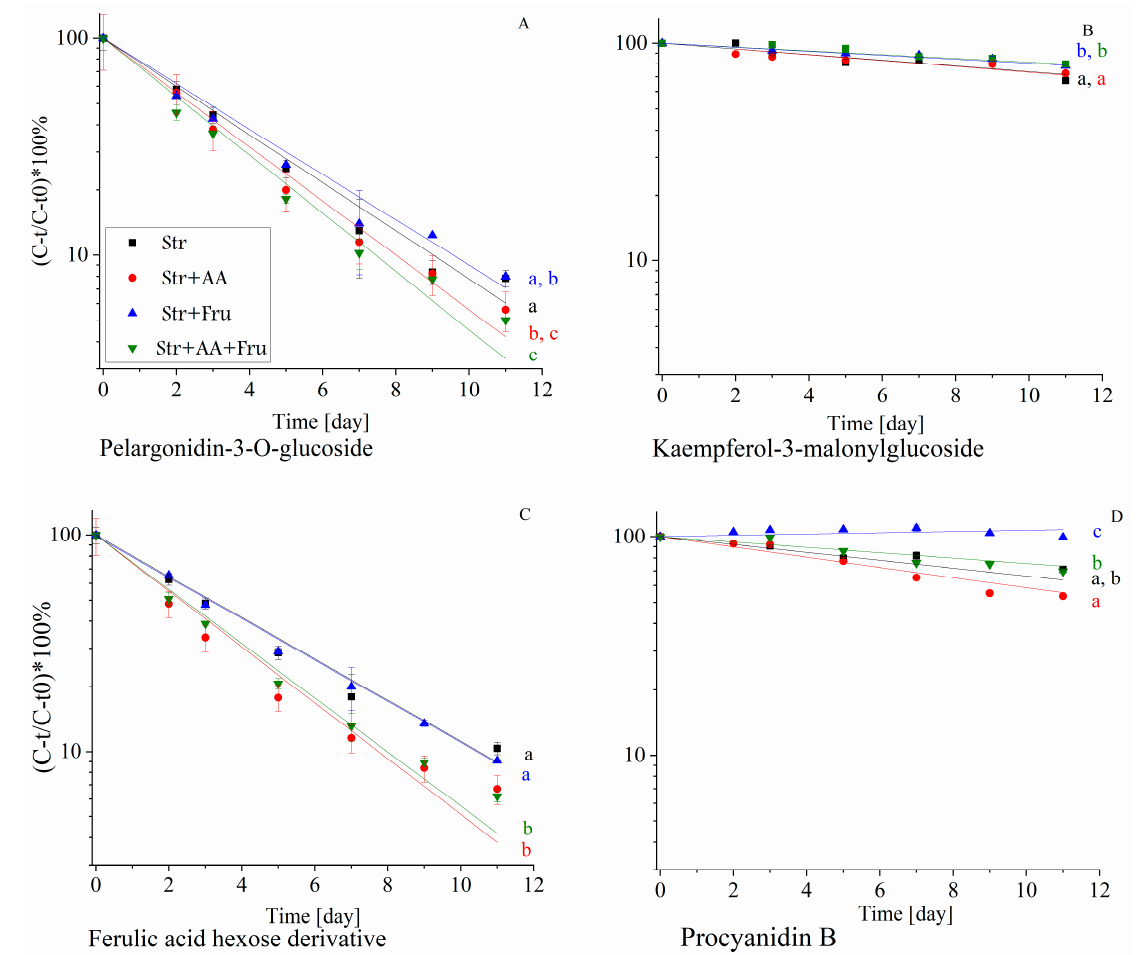
Figure 5. Relative concentration of polyphenols in the extract during shelf-life at 37 °C (citric buffer pH = 3, 50 mM) as function of the presence of ascorbic acid (AA, 0.022%) and fructose (Fru, 10%) ( A ) pelargonidin-3- O -glucoside, ( B ) kaempferol-3- O -malonylglucoside, ( C ) ferulic acid hexose derivative, ( D ) procyanidin B. * Error bars represent standard error (n = 2). * Small letters near the regression line represent significant differences ( p < 0.05), according to the colors in the legend.